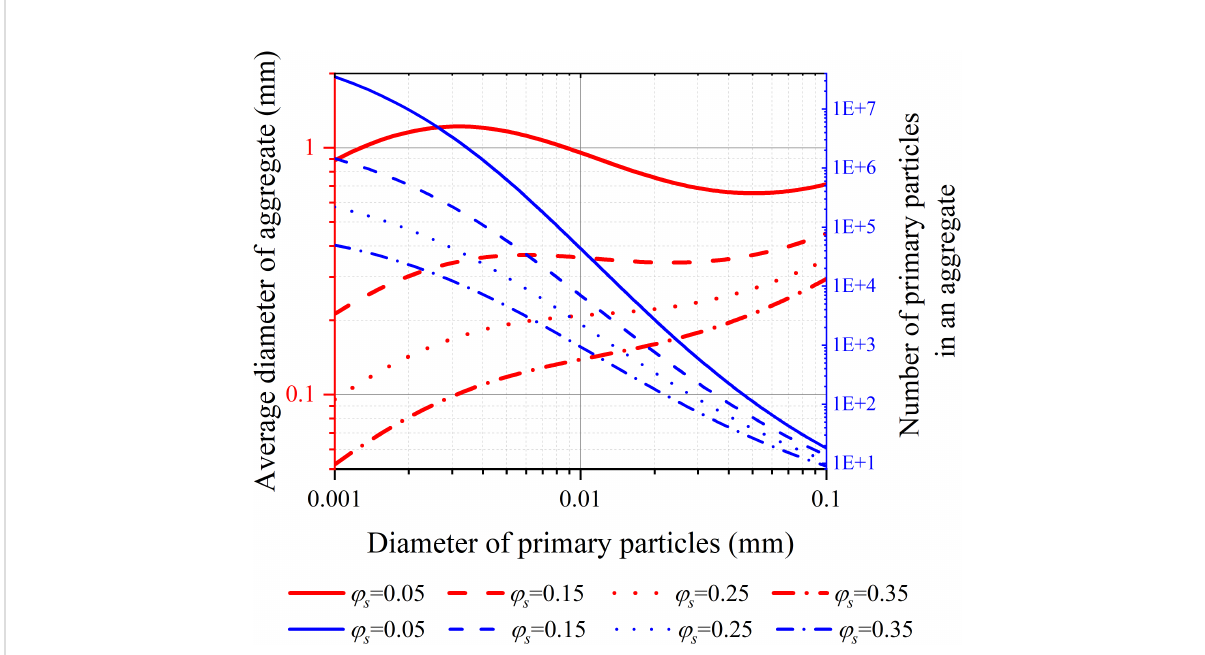
FIGURE 8 The predicted aggregate diameter and the average number of primary particles in an aggregate varying with the primary particle diameter and the solid volume fraction.